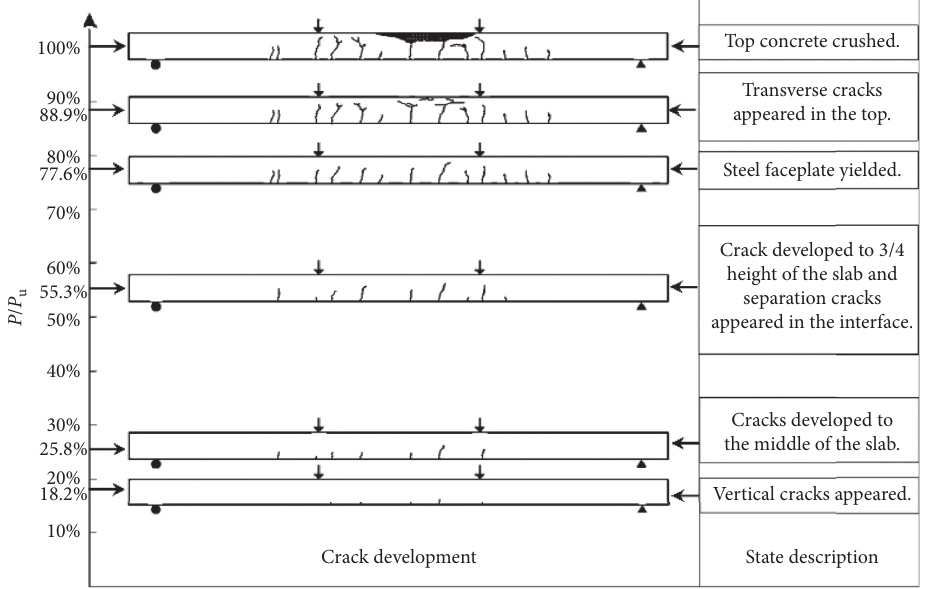
Figure 9: Description of the failure process of HSC1-1.